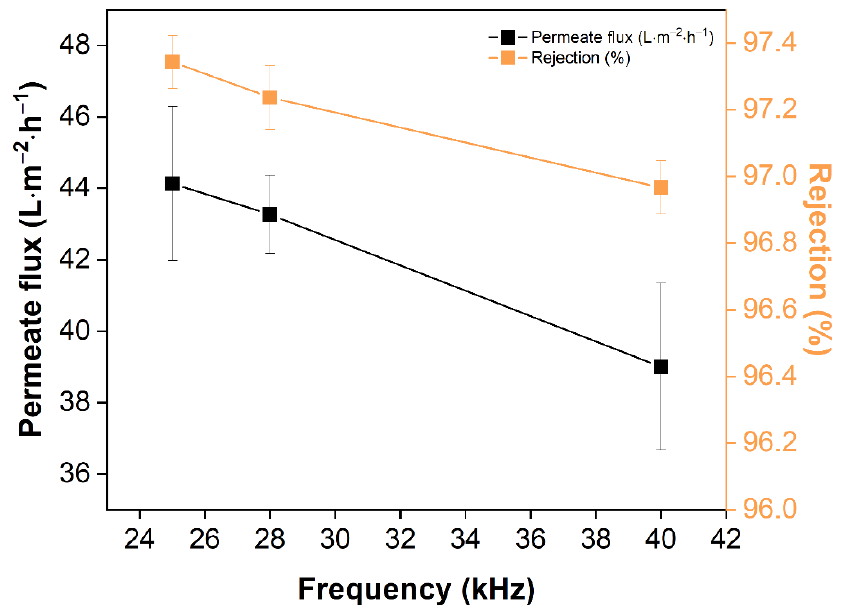
Figure 7. Permeate flux (black dot line) and rejection (orange dot line) of RO membrane after 10